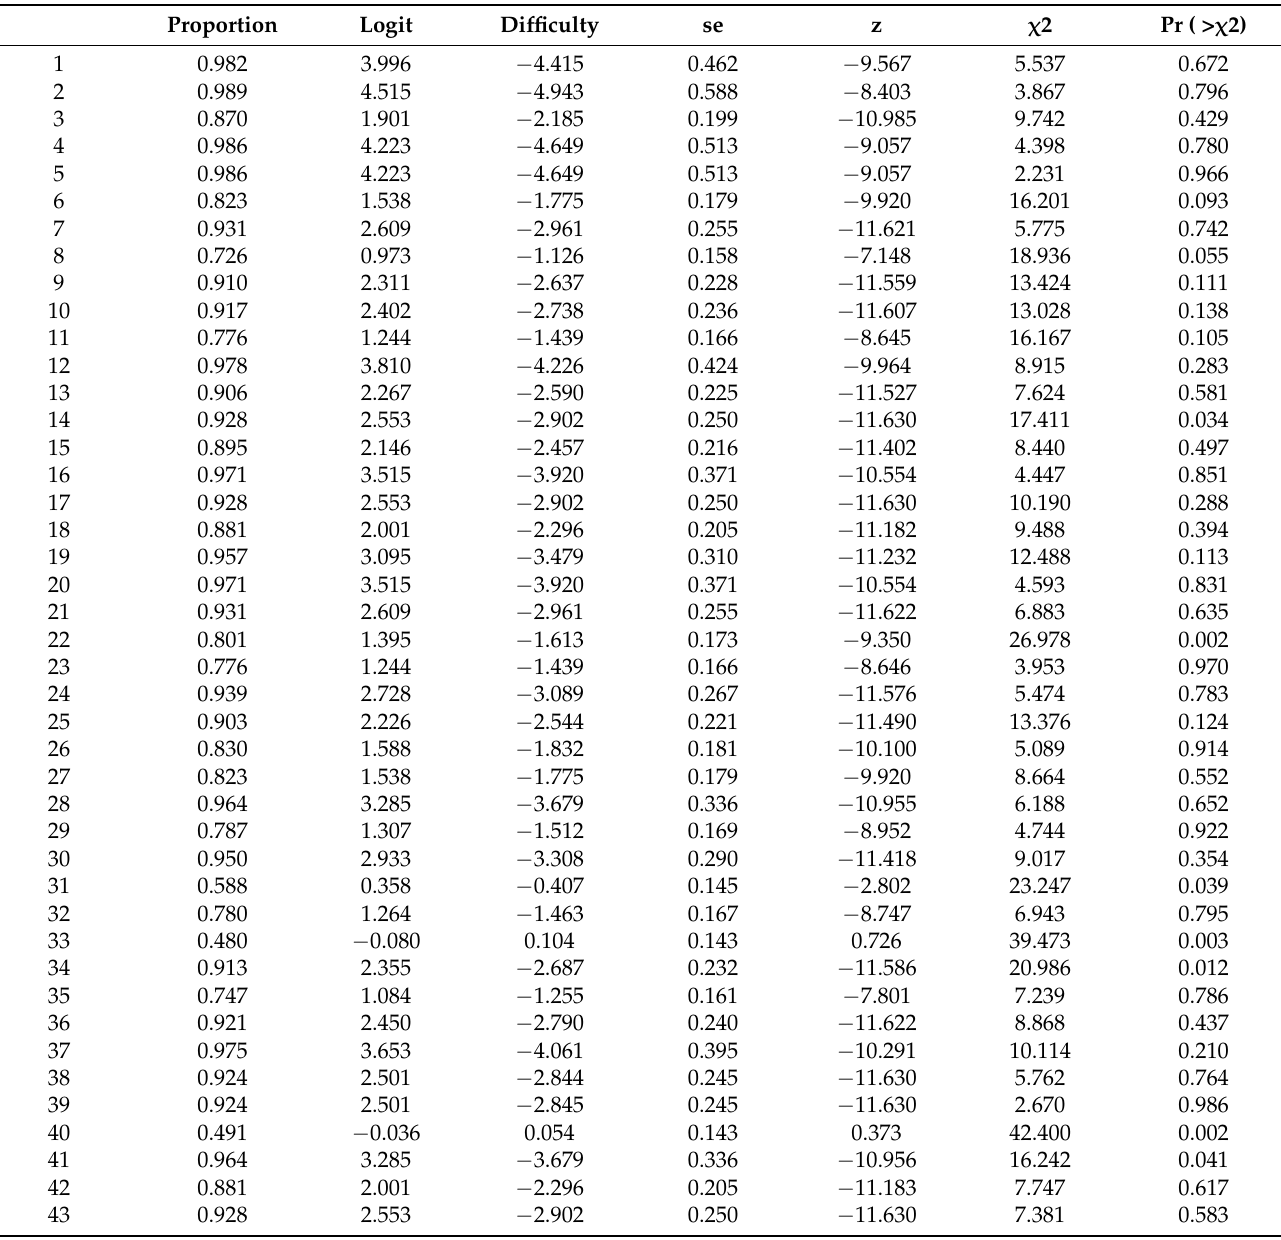
Table 3. Item difficulty and item fit statistics (Monte–Carlo